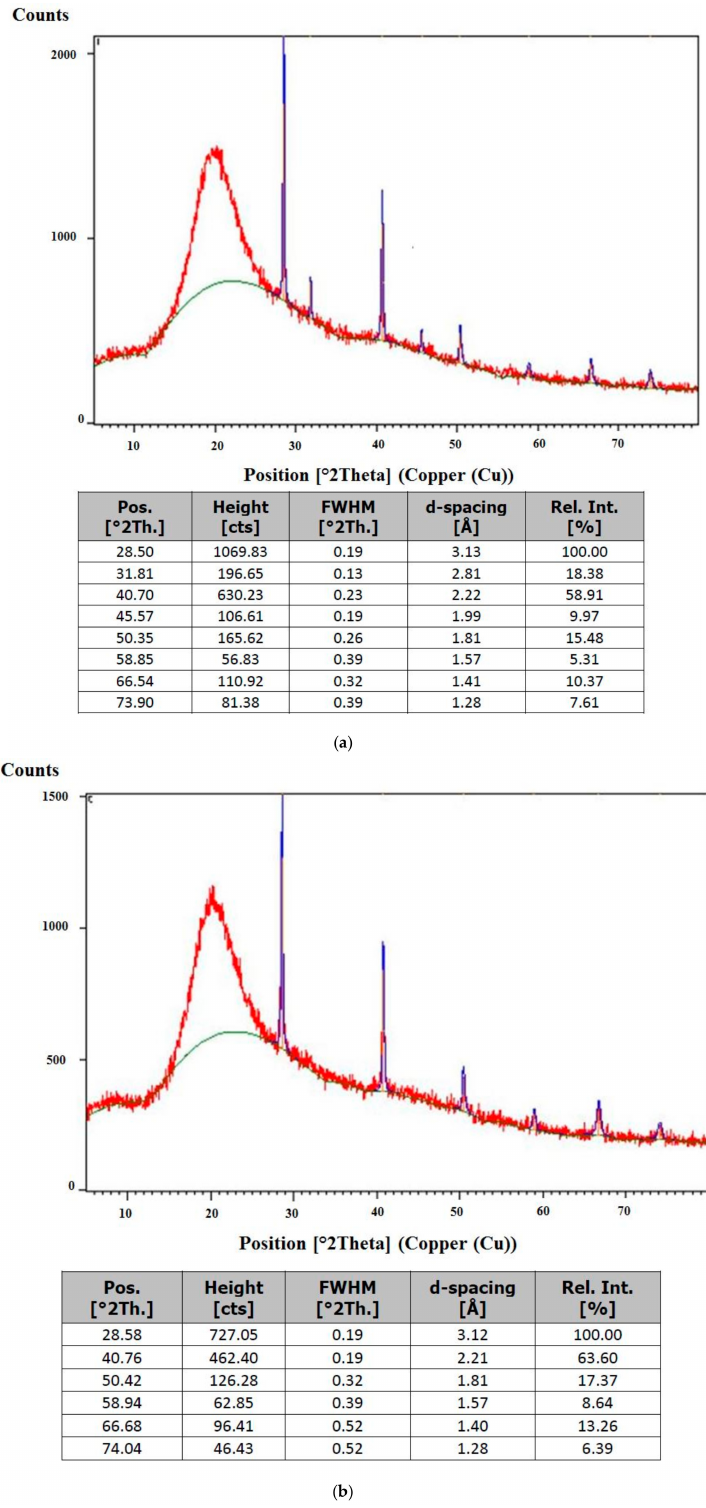
Figure 4. XRD (( a , b ) show the di ff ractogram and peak list of squalene-loaded liposome (5% ( w / w ) mixed soy lecithin (ML), 0.5% ( w / w ) squalene (SQ), 0.3% ( w / w ) cholesterol (CH) and 0.75% ( w / w ) Tween80 (TW80)) and squalene (SQ)-free liposome (control) (5% ( w / w ) mixed soy lecithin (ML), 0.3% ( w / w ) cholesterol (CH) and 0.75% ( w / w ) Tween80 (TW80)),